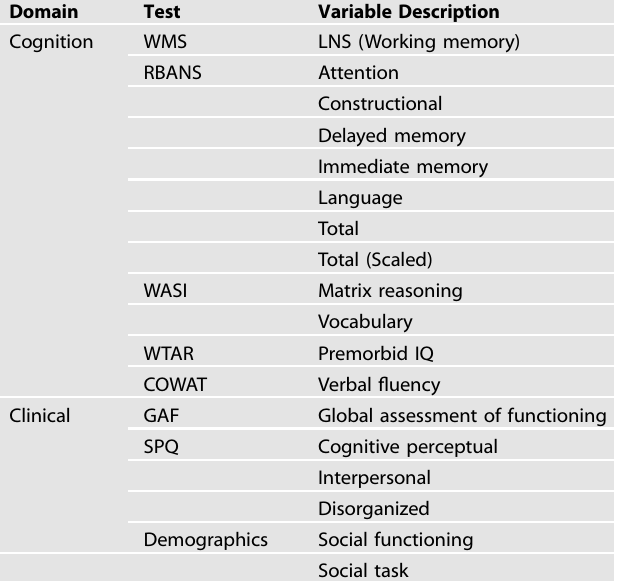
Table 2. Clinical and cognitive